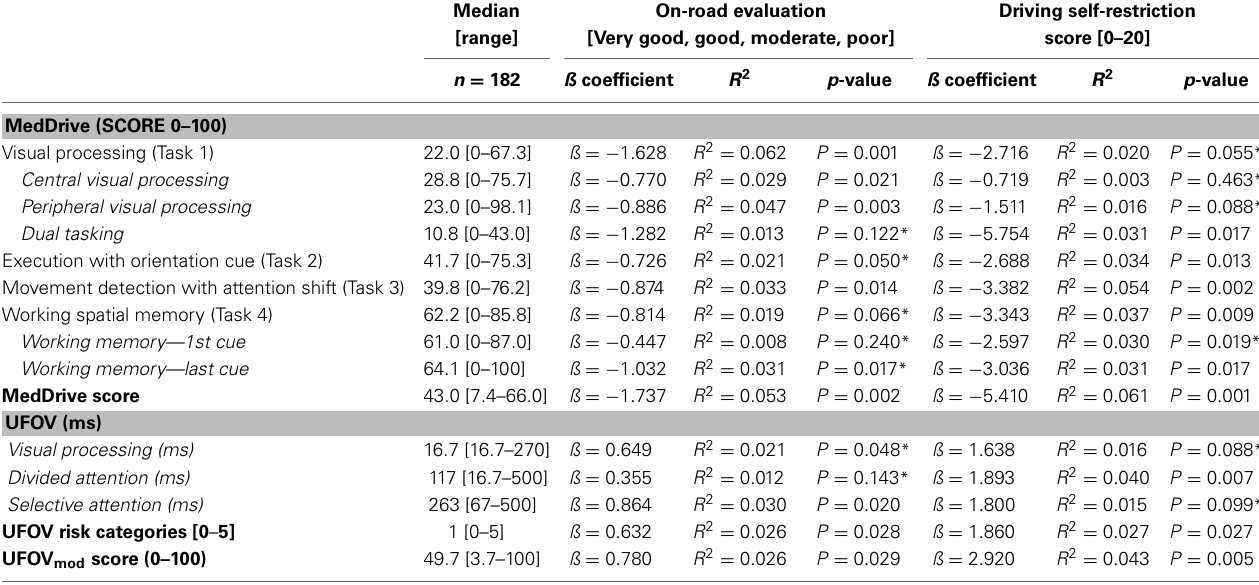
Table 4 | Computed tasks’ associations to driving behavior ( n =